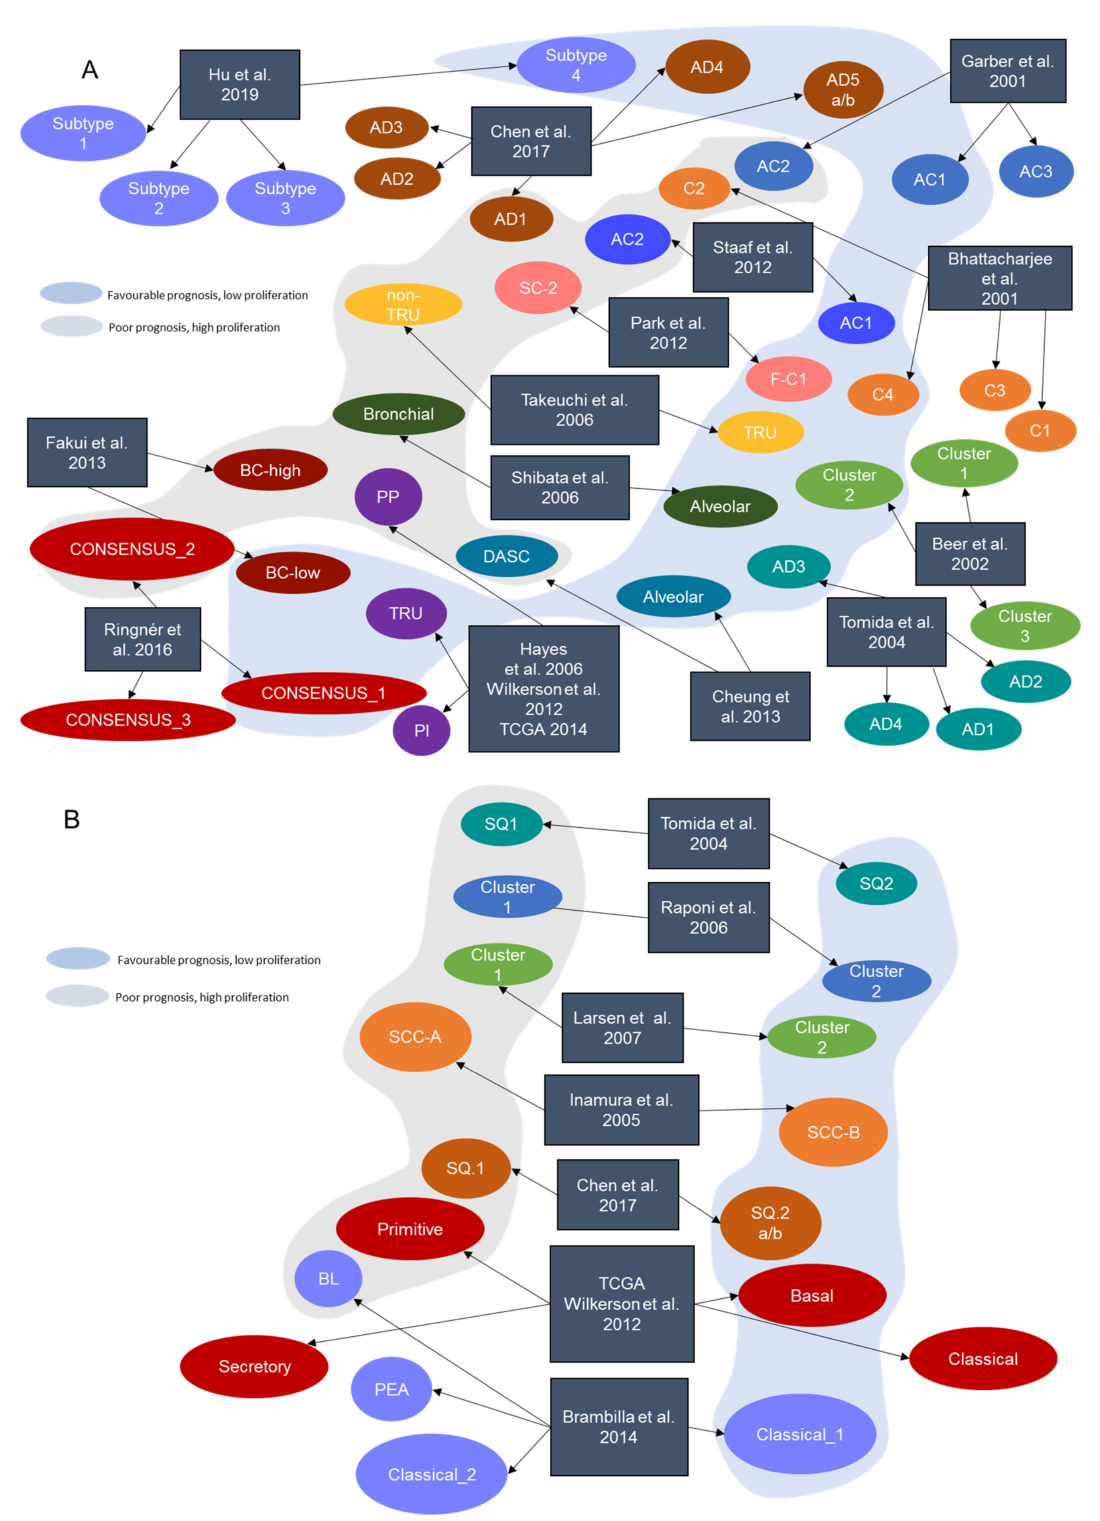
Figure 1. Intrinsic NSCLC transcriptional subtypes. Some of the NSCLC transcriptional subtypes described by different research groups are clearly comparable, based on prognostic and molecular characteristics (same color shadows). ( A ) Transcriptional subtypes described in LUAD. ( B ) Transcriptional subtypes described in LUSC. In both histologies, the blue shadow represents a set of tumors with better prognosis and low proliferation-related pathways activity whereas the grey shadow represents a subset of tumors with worse prognosis and a proliferative and more aggressive